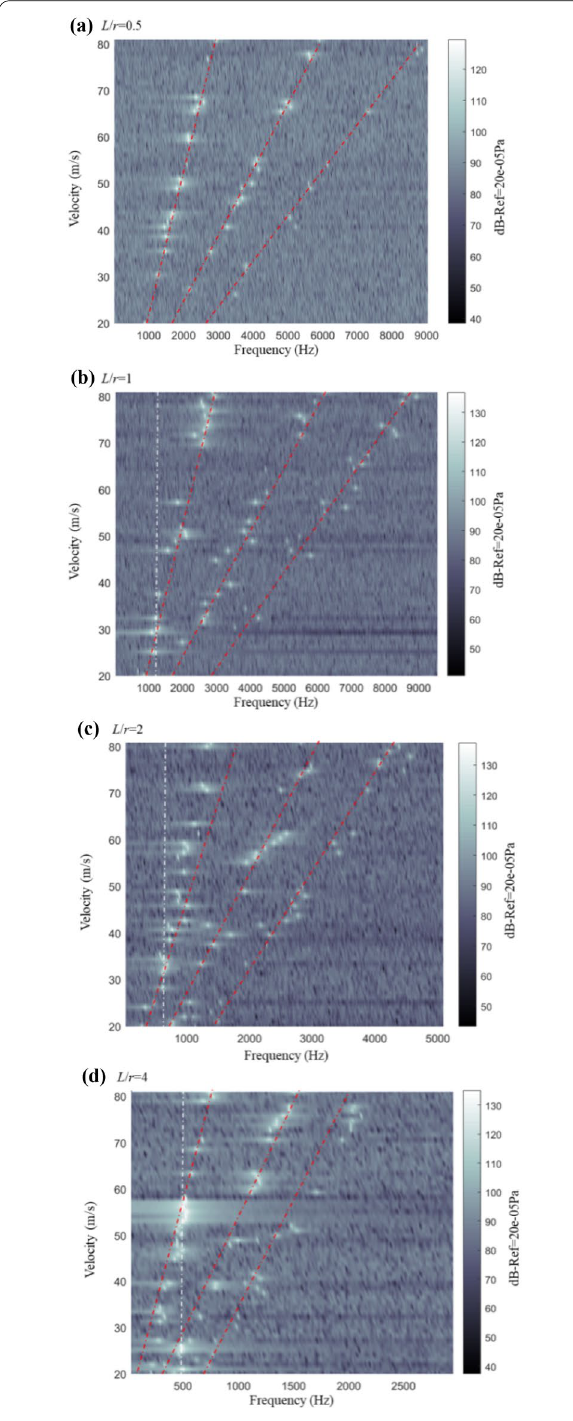
Figure 4 Speed-dependent spectrogram measured at cavity